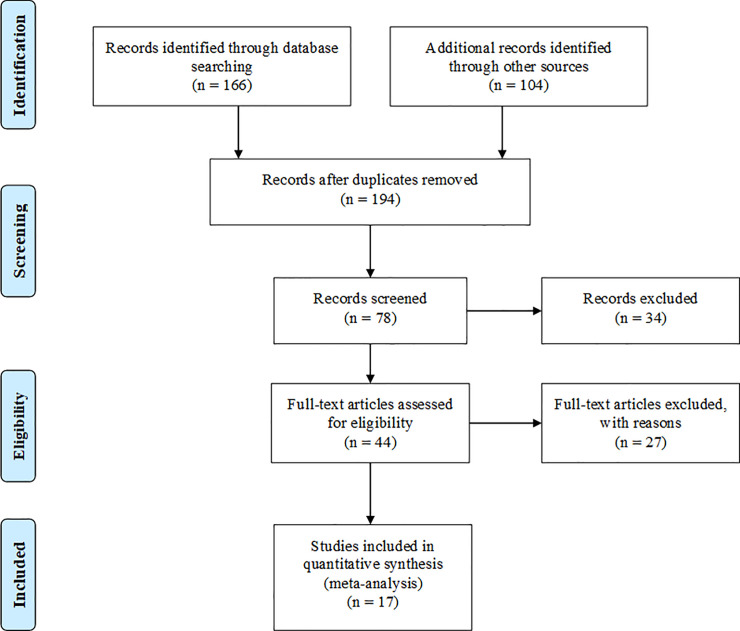
A PRISMA flow diagram detailing the literature search strategy and study selection for the meta-analysis.